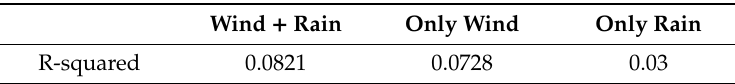
Table 1. R-squared values of the